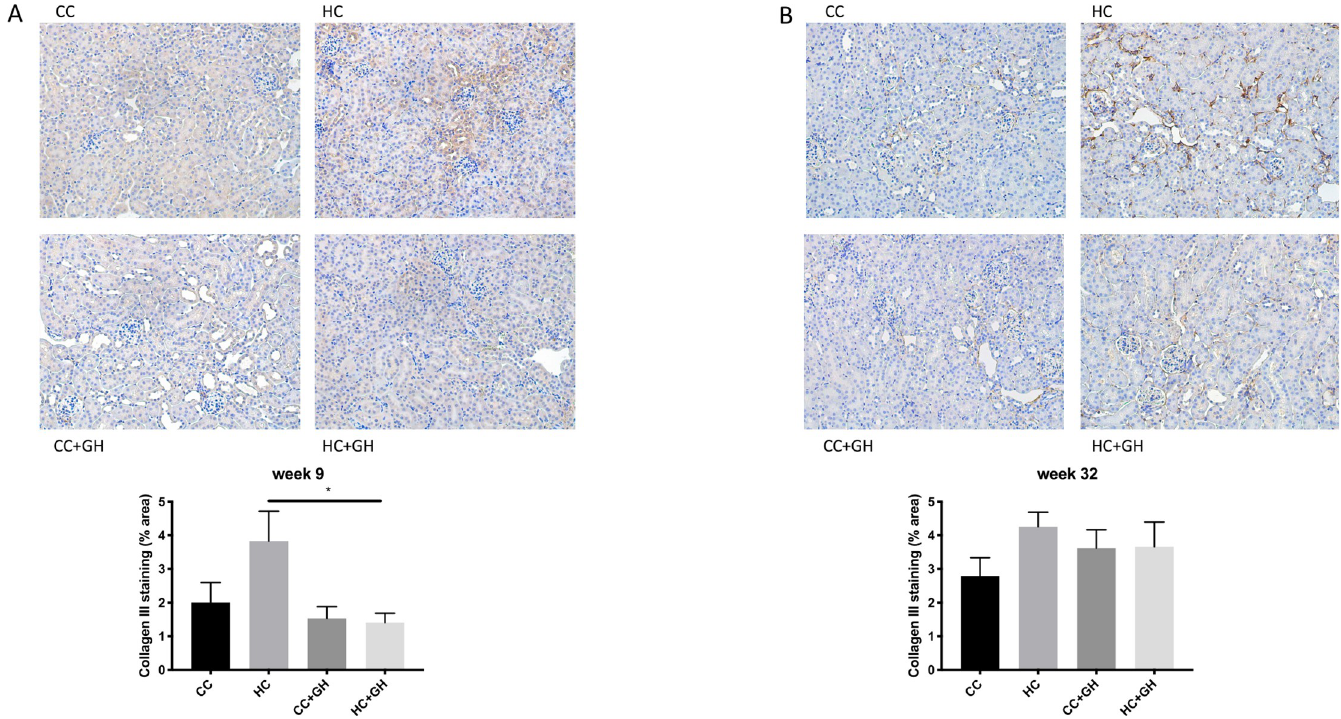
Fig 7. Renal fibrotic changes as measured by collagen III immunohistochemistry. (A) Week 9 offspring representative images of collagen III staining at 200x magnification, and quantitation (B) Week 32 offspring representative images of collagen III staining at 200x magnification, and quantitation. Results expressed as mean ± SEM, n = 6. � p <